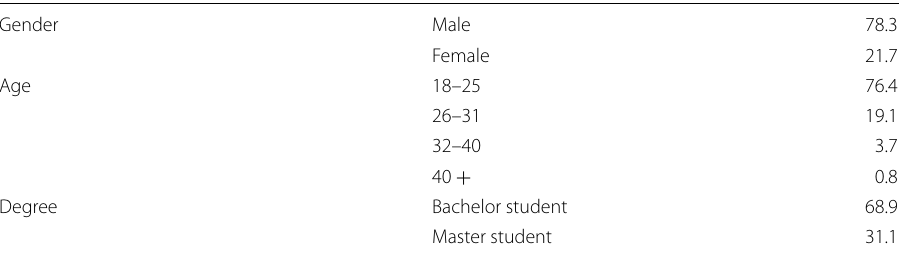
Table 1 Background of the surveyed students